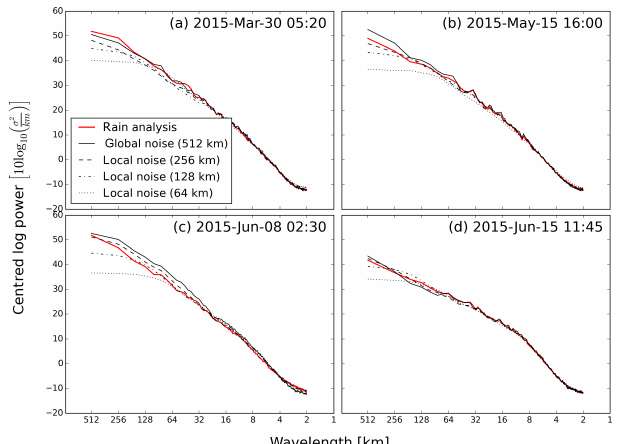
Figure 11. The 1-D centred power spectra of precipitation fields for the four case studies are represented in red. In black are the corre- sponding average spectra of 20 non-parametric noise field realisa- tions with decreasing window